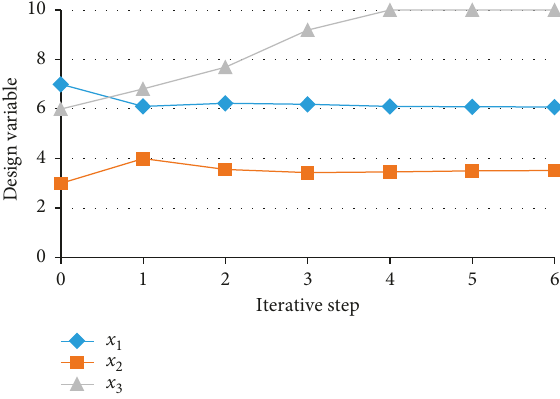
Figure 17: Iterative process of design variables.